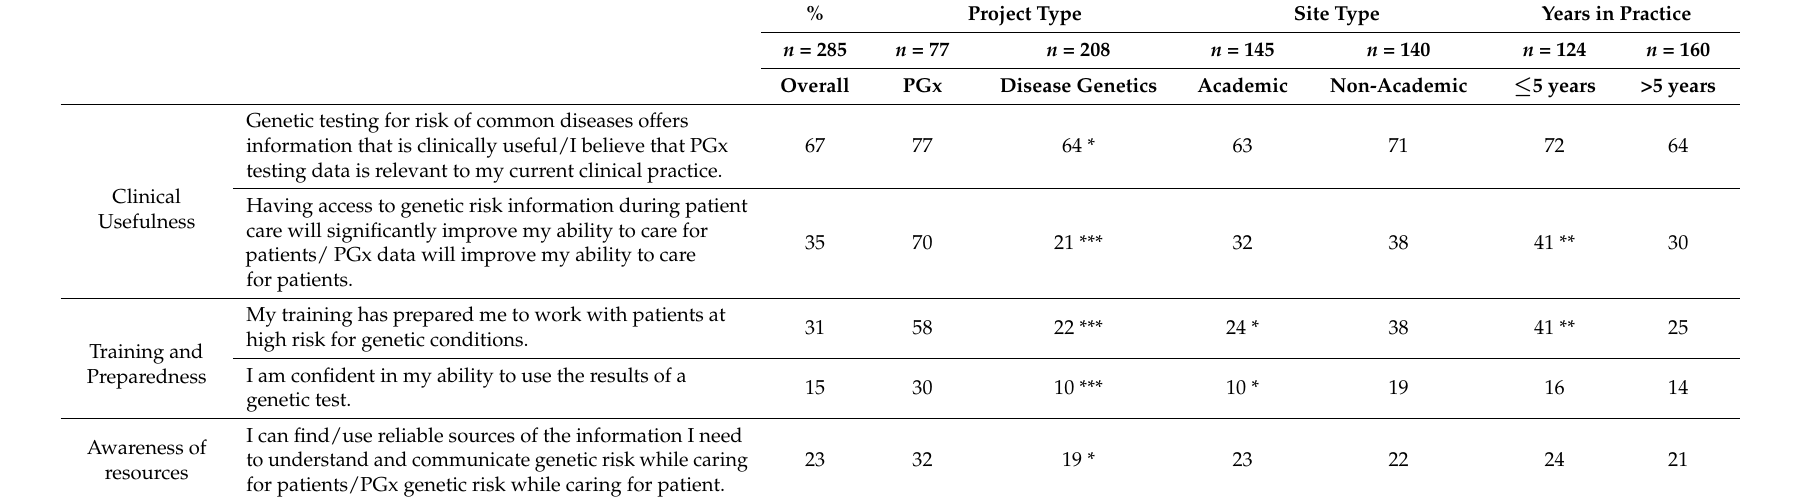
Table 3. Physicians attitudes and perceptions towards genomic medicine